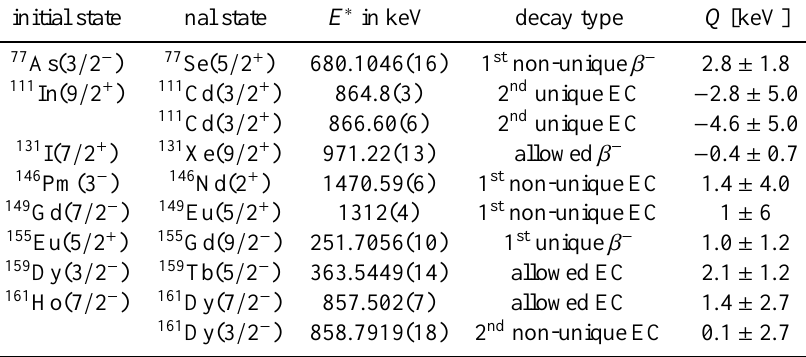
Table 1. Potential candidate transitions with ultra-low Q values. The first column gives the initial ground state of the listed nucleus and the second column the final excited state of the listed nucleus. The third column gives the experimental excitation energy with the experimental error. The fourth column gives the decay type and the last column the derived experimental decay Q value in units of